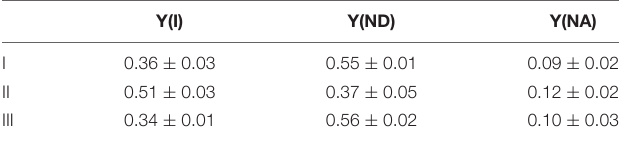
in phase β . Compared with the redox state of P700 at point I, the addition of H 2 O 2 increased incident quantum yield of PSI, Y(I), and decreased Y(ND), at point II ( Table 1 ). Thereafter, both Y(I) and Y(ND) recovered to the original values at point III ( Table 1